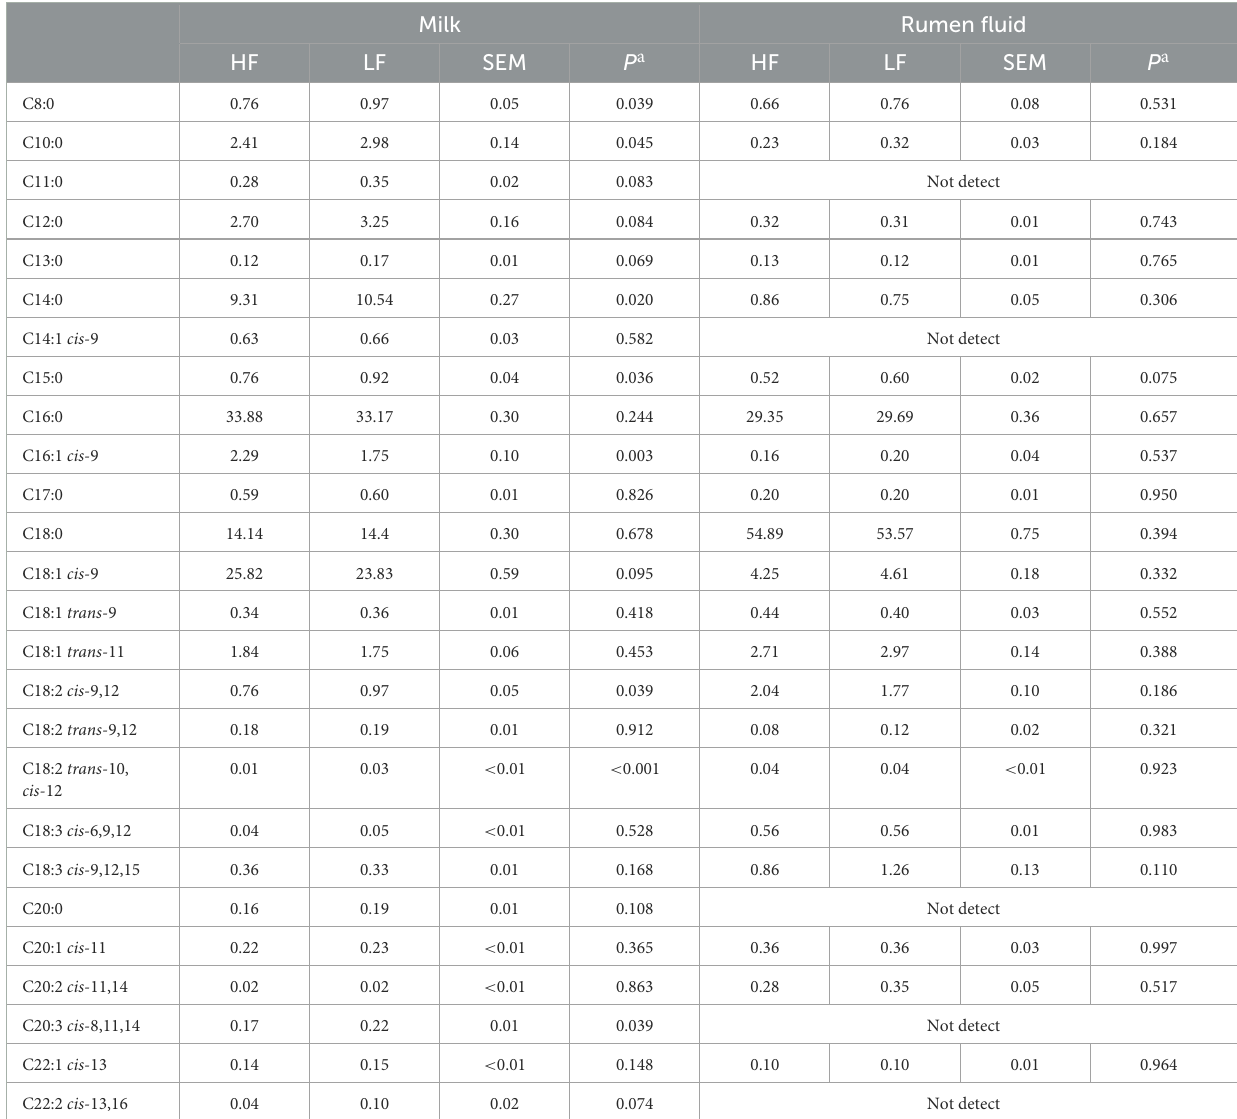
TABLE 3 Fatty acid (longer than 8C) compositions in milk and rumen fluid of Holstein cows with highest milk fat percentage (HF) or lowest milk fat percentage (LF) (g/100g of TFA).